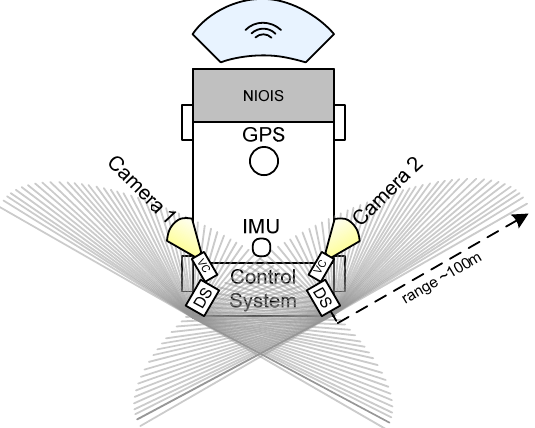
Figure 1. Typical structure of terrestrial self-driving vehicles equipped with nonintrusive object inspection system. Top view.